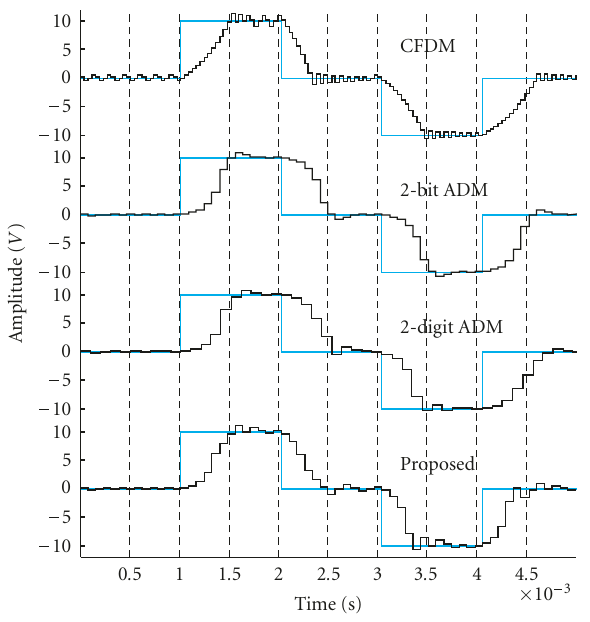
Figure 4: Bipolar returned-to-zero pulse response of the four sys- tems for the same output baud.